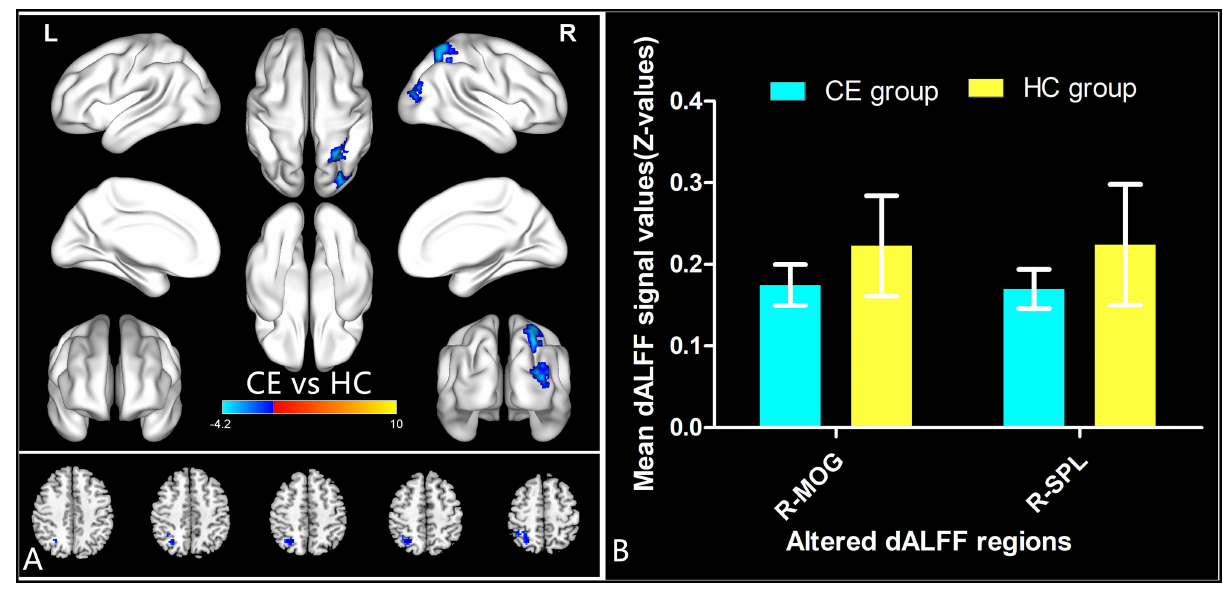
FIGURE 3 | dALFF differences between two groups (window length = 70 TR, window step = 1 TR) (A) . The mean of altered dALFF values between two groups (B) . CE, comitant exotropia; HC, health control; dALFF, the dynamic amplitude of low-frequency fluctuation; MOG, middle occipital gyrus; SPL, superior parietal lobule; R,